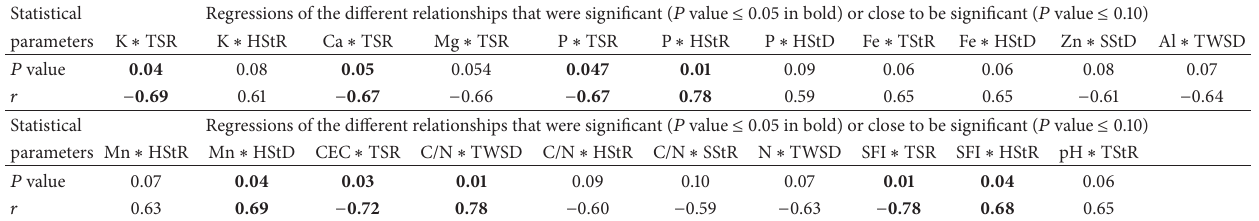
Table 3: ANOVA results ( 𝛼 = 0.05 ) and correlation coefficient ( 𝑟 ) of the different regressions with 𝑃 value ≤ 0.10. Statistical Regressions of the different relationships that were significant ( 𝑃 value ≤ 0.05 in bold) or close to be significant ( 𝑃 value ≤ 0.10)